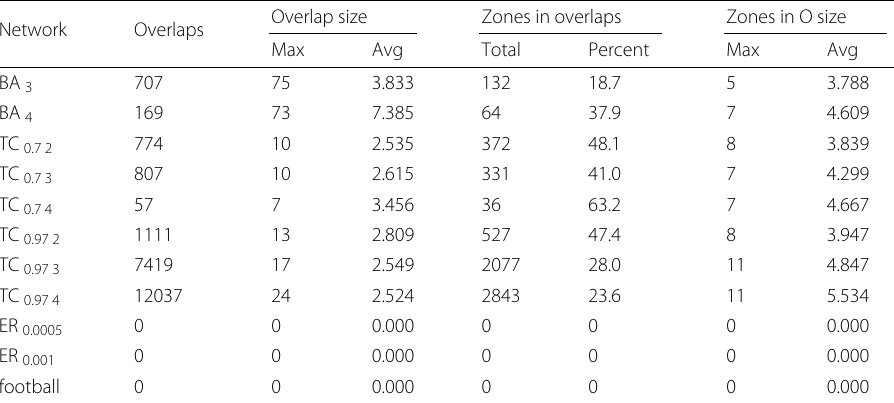
Table 10 Properties of zone overlaps in generated